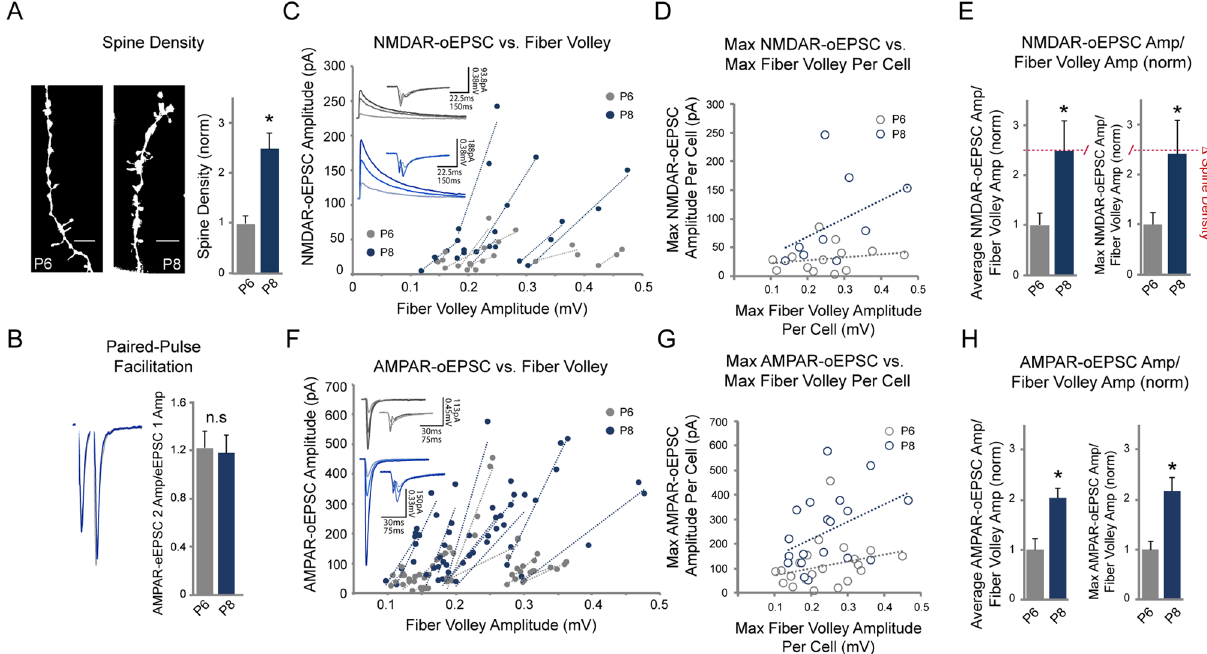
Figure 2. Increased NMDAR-oEPSC/FV amplitude ratio mirrors glutamatergic synaptogenesis . (A ) Hippocampal slice cultures from P8 rats have increased spine density compared to those from P6 rats. (Left) Representative CA1 dendritic spine images in P6 vs. P8 slices, neurons transfected with GFP. (Right) Bar graph showing averaged spine density in P6 vs. P8 slices normalized to P6 slices (P6: 0.12 ± 0.019 spines/µM, n = 11, P8: 0.29 ± 0.039 spines/µM, n = 14, p = 0.001, Student’s t test). For ( B )–( H ), Wilcoxon rank sum test was used; * p < 0.05. ( B ) Representative traces (left) and mean ± SEM paired-pulse facilitation ratios for P6 and P8 CA1 pyramidal neurons (right) (P6: n = 11; P8: n = 7, p = 1, n.s., not significant). ( C ) NMDAR-oEPSC’s plotted as a function of fiber volley amplitude over a range of stimulation strengths (range = 3 + light intensity levels per cell); measurements from each cell were fitted with a linear regression line. Inset representative traces demonstrate increasing fiber volley amplitude and increasing NMDAR-oEPSC amplitude. ( D ) Max NMDAR-oEPSC/FV amplitude measurements, taken at maximum optical stimulation, for each cell in P6 and P8 slices. Each point represents the Max NMDAR-oEPSC/FV amplitude of one cell. Measurements from each group (P6 vs. P8) were fitted with a linear regression line. ( E ) (Left) Averaged and normalized NMDAR-oEPSC/FV amplitude ratio in P6 vs. P8 slices (P6: n = 7, P8: n = 8, p = 0.02). (Right) Averaged and normalized Max NMDAR-oEPSC/ FV ratio in P6 vs. P8 slices (P6: n = 10, P8: n = 13, p = 0.035). The red dotted line shows fold change in dendritic spine density in (A). ( F ) AMPAR-oEPSC’s plotted as a function of fiber volley amplitude over a range